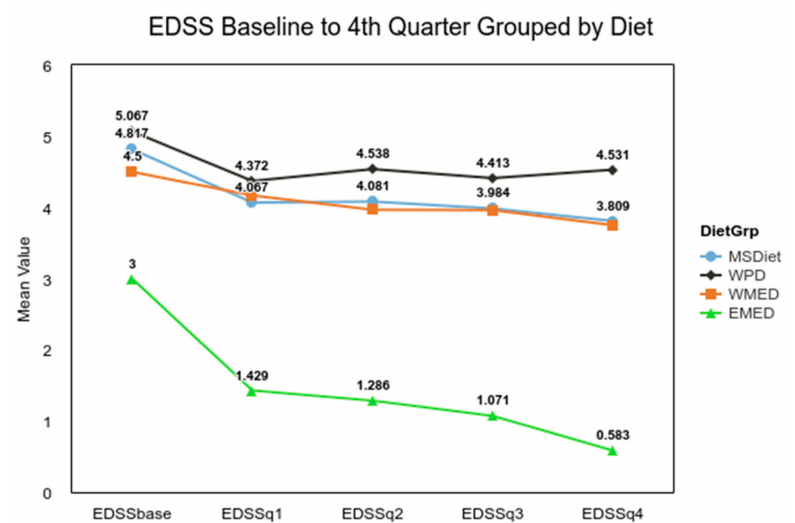
Figure 2. EDSS Baseline to 4th quarter grouped by diet. Note. n = 478 Baseline, Quarter 1 n = 421, Quarter 2 n = 336, Quarter 3 n = 284 and Quarter 4 n = 253. Q4. MS Diet = MSDiet, Western Pattern Diet = WPD, Western Mediterranean = WPD, and Eastern Mediterranean Diet = EMED. EDSS differences between groups were significant, F (3, 249) = 6.44, p < 0.001.